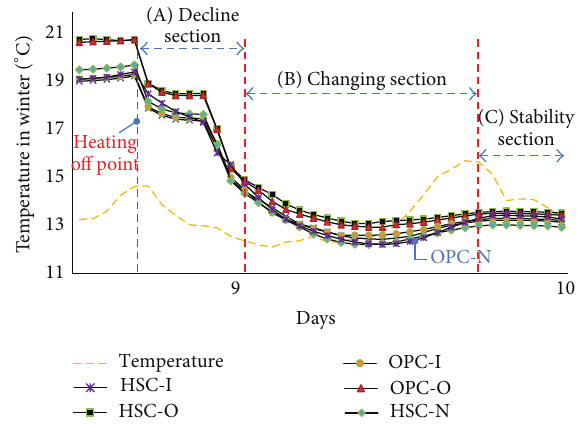
Figure 4: Measurement results of the mean temperature and average humidity of the specimens under winter conditions. Figure 5: Temperature change zone (A-1) after heating was turned